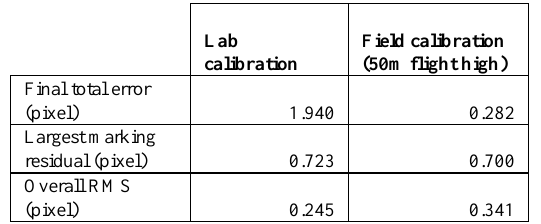
Table 3. Total final error and residuals of the camera calibration projects If the bars in the error chart (see Fig. 6) get smaller, the final total error decreases. Also checking the marking residuals is a good way to test the calibration quality. Photomodeler tutorial recommended having a largest marking residual less than 1.0 pixel (www.photomodeler.com). In both cases the largest marking residuals are less than 1.0 pixel. The lab calibration has 0.723 pixels and the field calibration 0.700 pixels (see table 3).